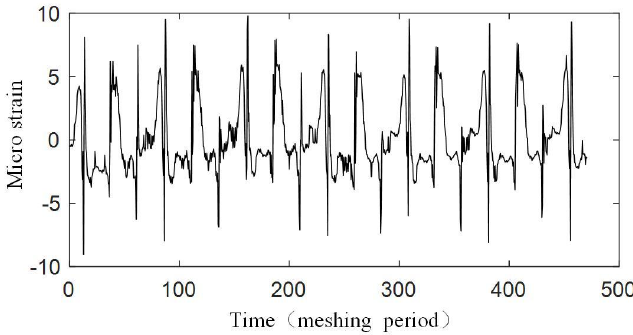
Figure 19. Original strain signal measured by FBG1.